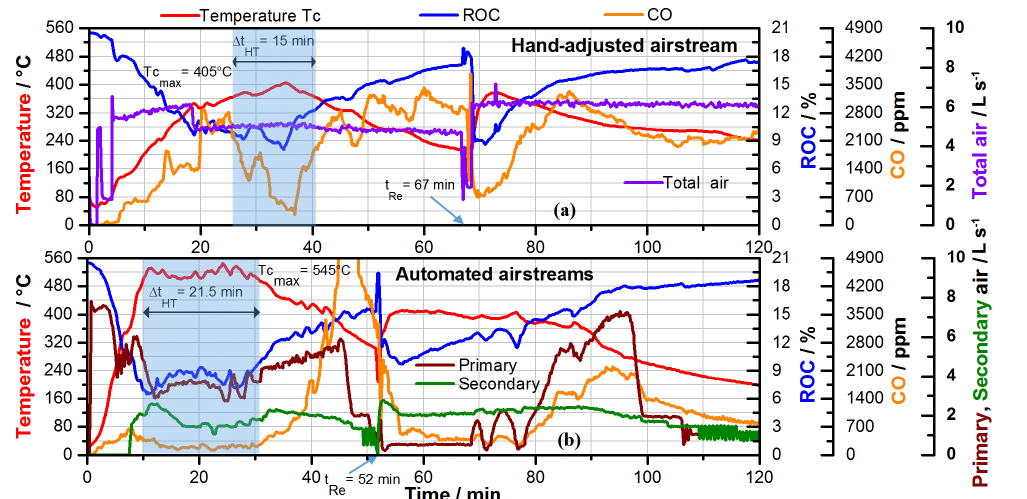
Figure 5. The differences in combustion airstreams and CO emissions (sampled with a high-temperature FTIR gas analysis system) of a hand-operated (a) and an automatically airstream-controlled (b) firewood combustion process in a Varia R fireplace. Due to the constructional design of the hand-operated fireplace, (a) only a total airstream could be sampled. The fireplace was reloaded with two additional logs on the glue bed at t Re . All CO concentration values are original data, i.e. not related to 13% ROC. Additionally, a catalyst in the experimental state (provided by the Deutsches Biomasseforschungszentrum (DBFZ), Leipzig, Germany) was used in the fireplace with automatic airstream control to study the improvement of the post combustion and the reduction in the